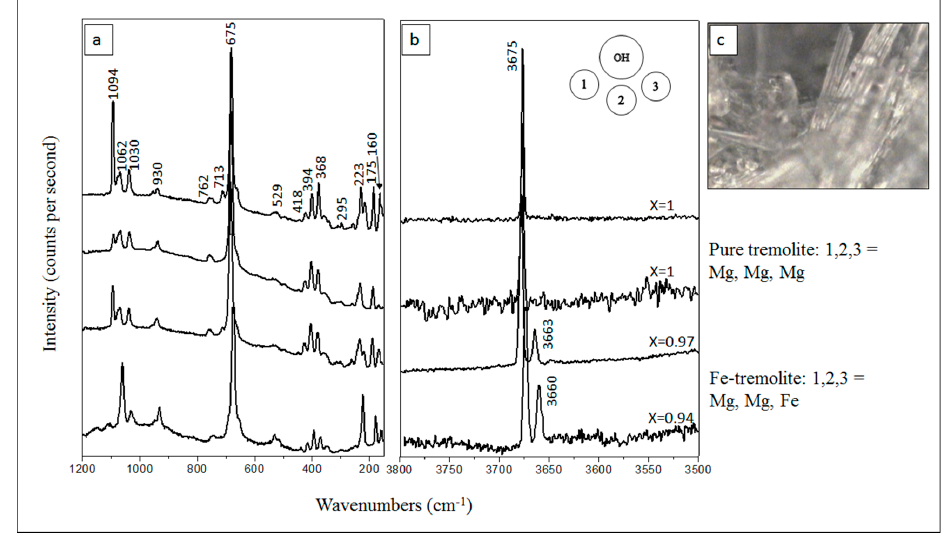
Figure 3. Raman spectra at low ( a ) and at high ( b ) wavenumbers of pure Mg-tremolite and Fe-tremolite from selected samples. μ -Raman Spectroscopy image of the fibrous tremolite ( c ) performed on rock slabs.